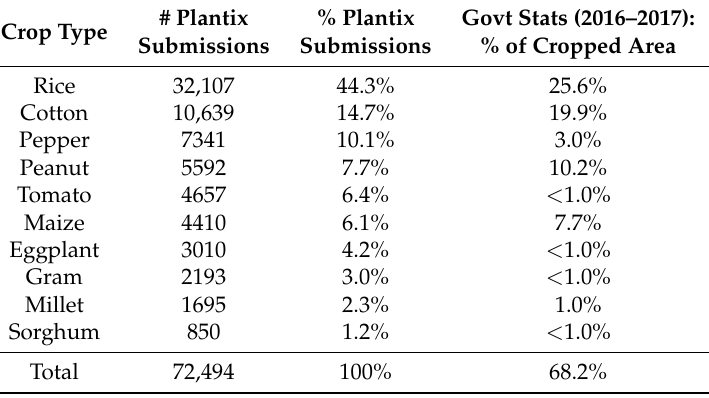
Figure 3. Explanatory diagram of the methods presented in this paper. Raw datasets are shown on the left; the data are cleaned and input to feature extraction and machine learning models, and the methods output crop type predictions that are validated against both a hold-out set of ground labels and government statistics on crop area. Table 1. Kharif season crop type distribution. Submission counts are shown for the filtered Plantix dataset and compared to government crop area statistics for Andhra Pradesh and Telangana in 2016–2017. For comparison, Indian state agriculture departments collected 11,469 points nationally in both kharif and rabi seasons in 2017–2018